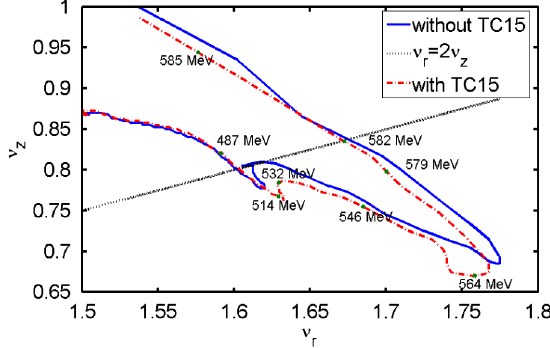
FIG. 5. Tune diagram with and without